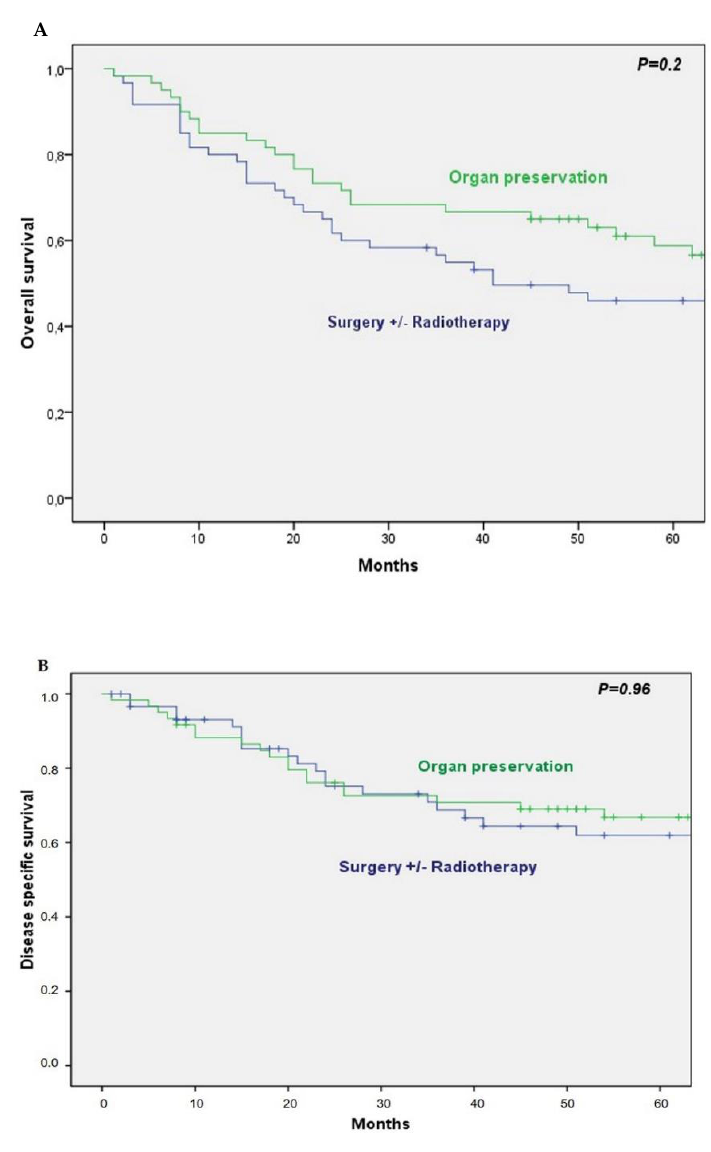
Figure 1. ( A ) Overall survival by treatment; ( B ) disease-specific survival by treatment.